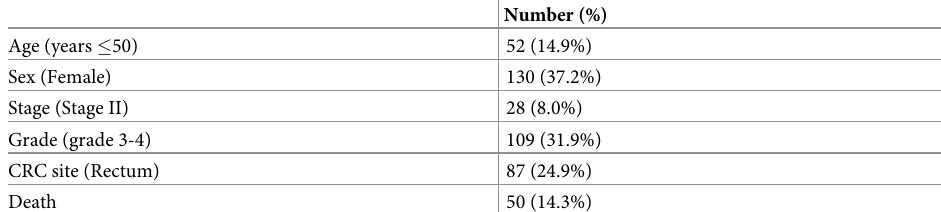
Table 2. Patient characteristics of the subsample analysed in the DACHS case study.